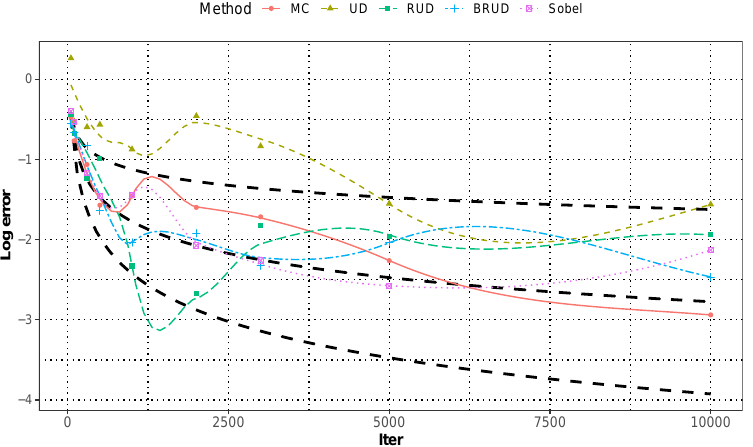
Figure 6. The approximation error of integration 3 for each runs in dimension s = 5 with Locally Weighted